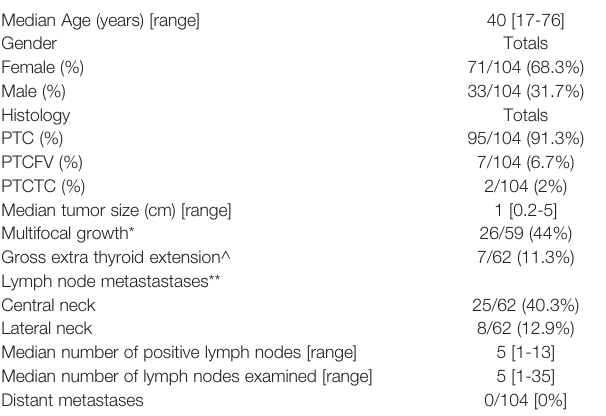
TABLE 1 | Clinical characteristics of the study participants affected by thyroid cancer. Clinical and pathologic features of patients affected by thyroid cancer